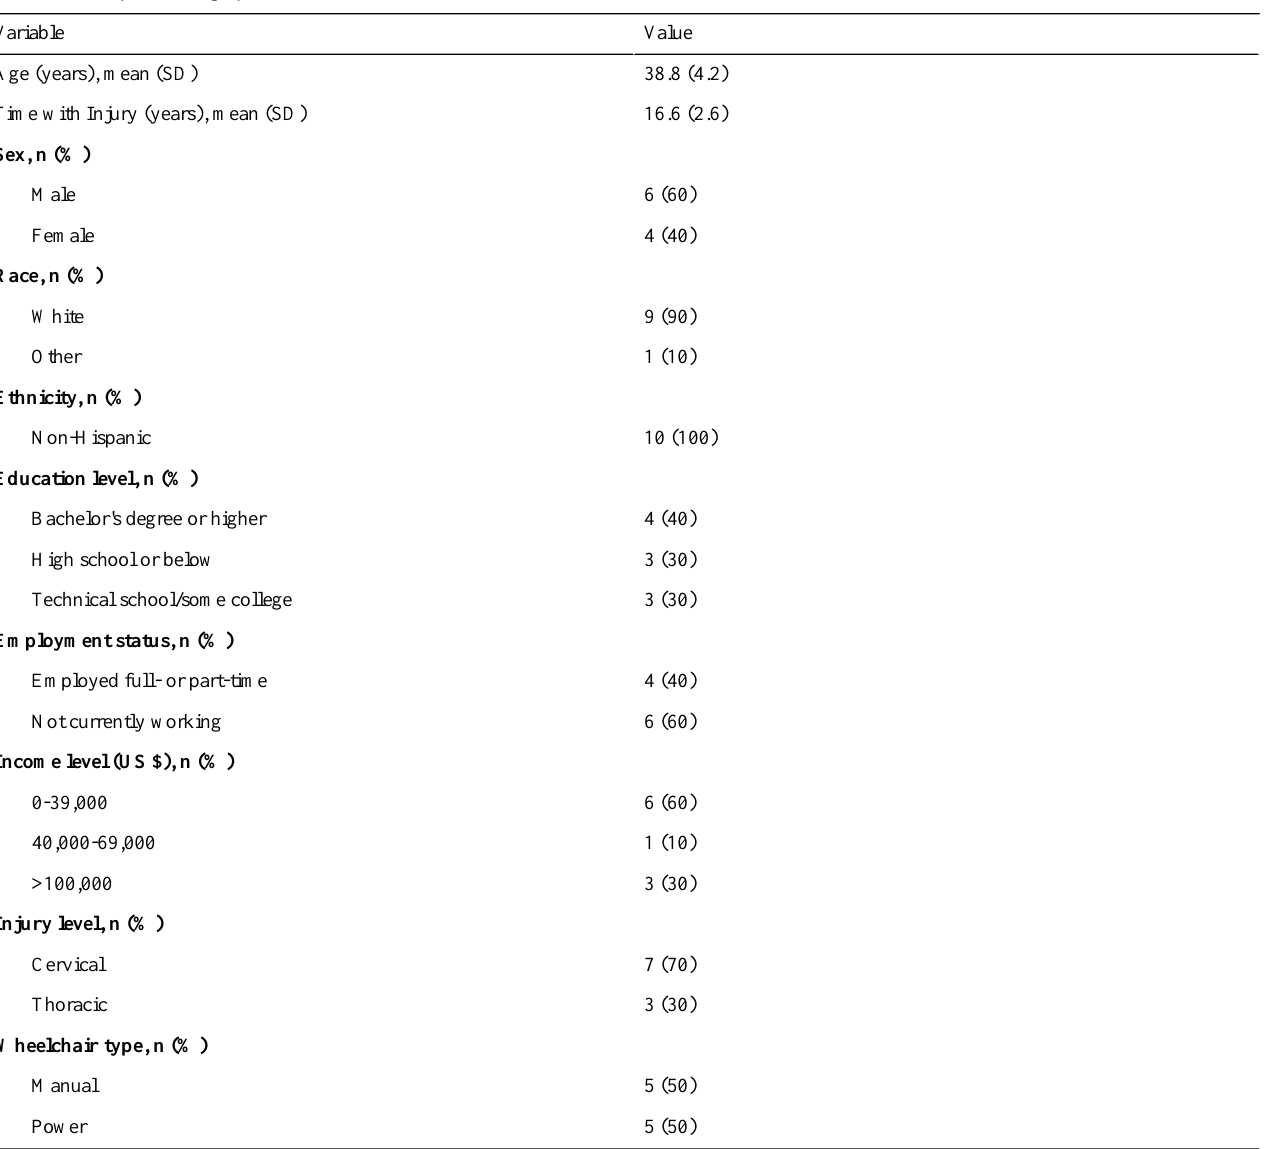
Table 1. Participant demographics (N=10).